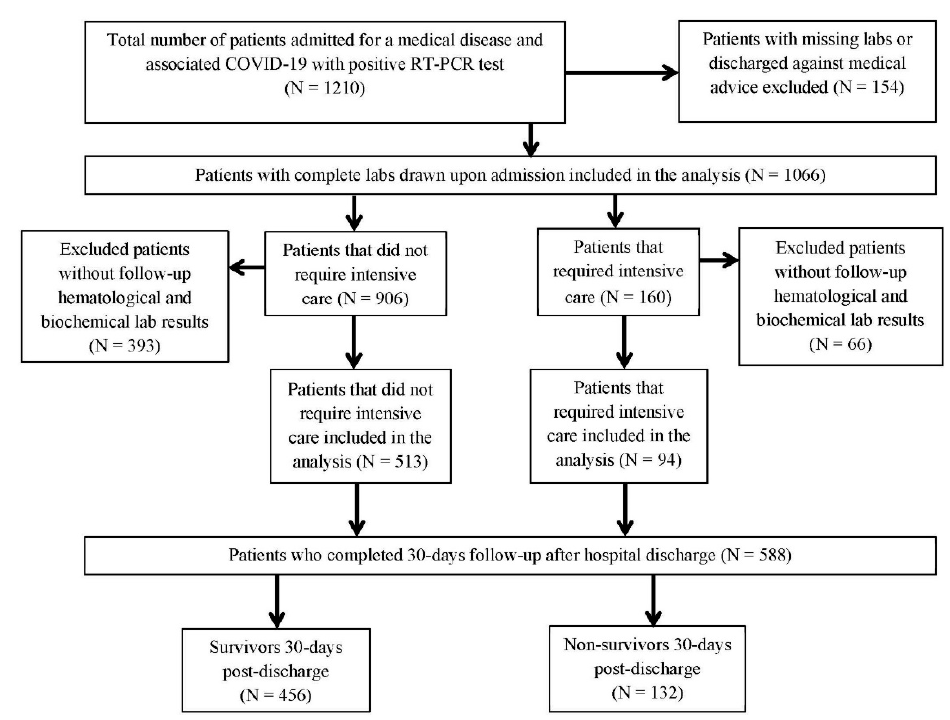
Figure 1. Flow chart of the study cohort.